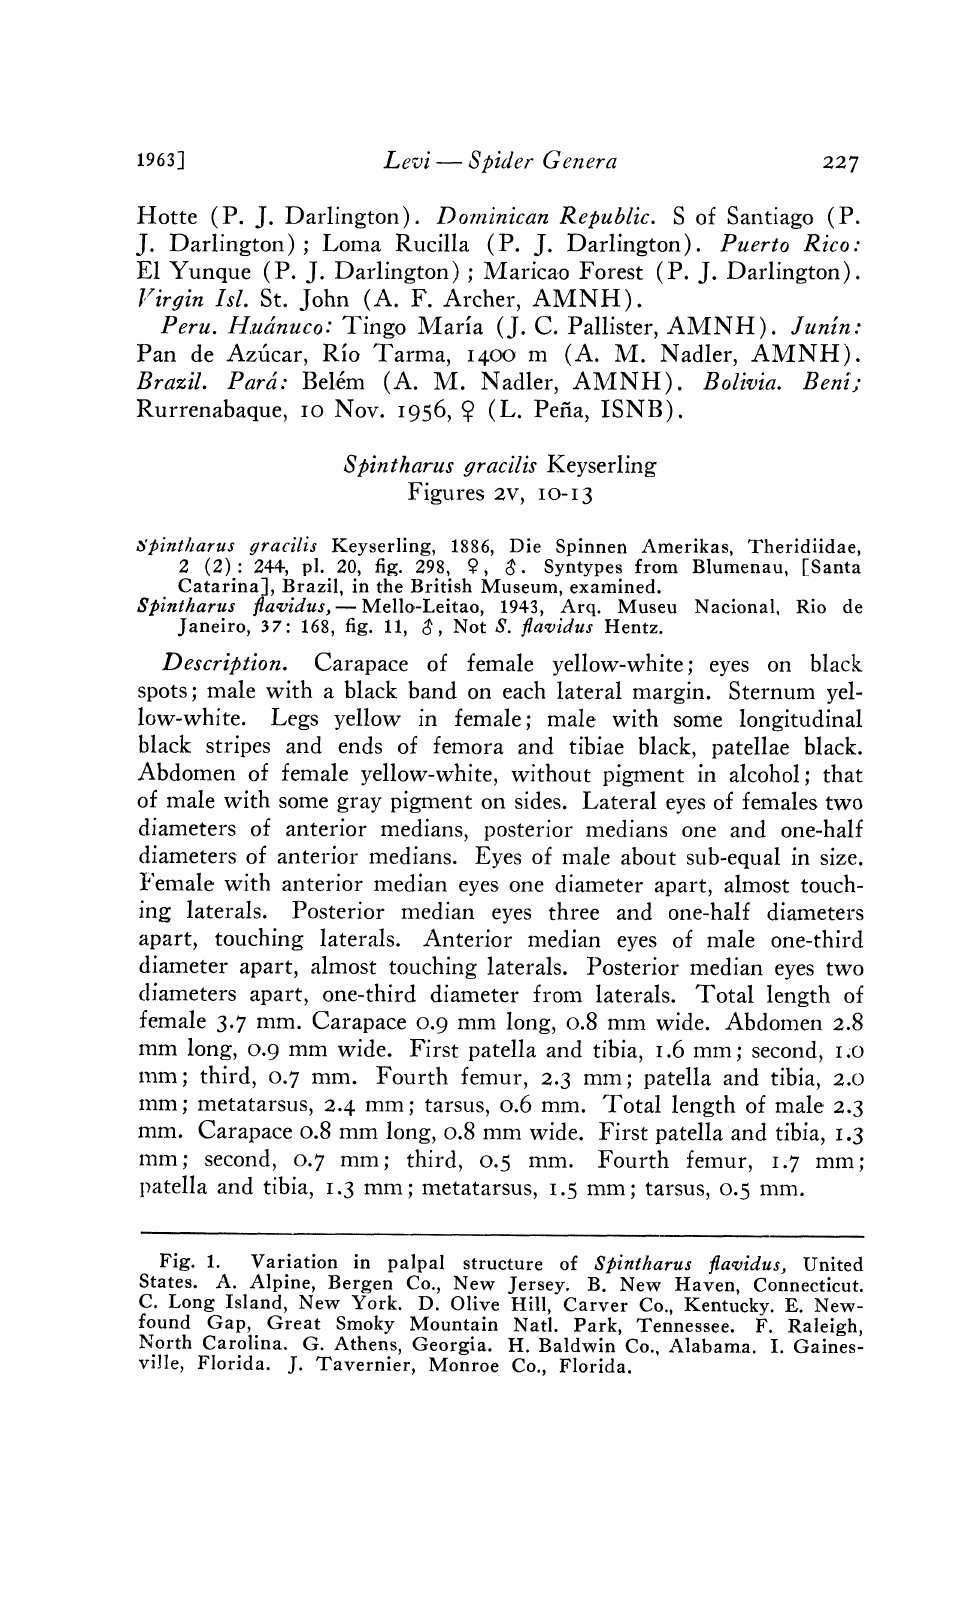
Fig. 1. Variation in palpal structure of 8pintharus flaaidus, United States. A. Alpine, Bergen Co., New Jersey. B. New Haven, Connecticut. C. Long Island, New York. D. Olive Hill, Carver Co., Kentucky. E. New- found Gap, Great Smoky Mountain Natl. Park, Tennessee. F.